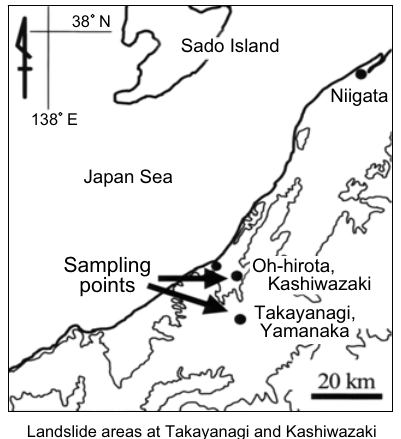
Fig. 2 – Locality map of landslide areas shows sampling points at Takayanagi and Kashiwazaki in Niigata prefecture in